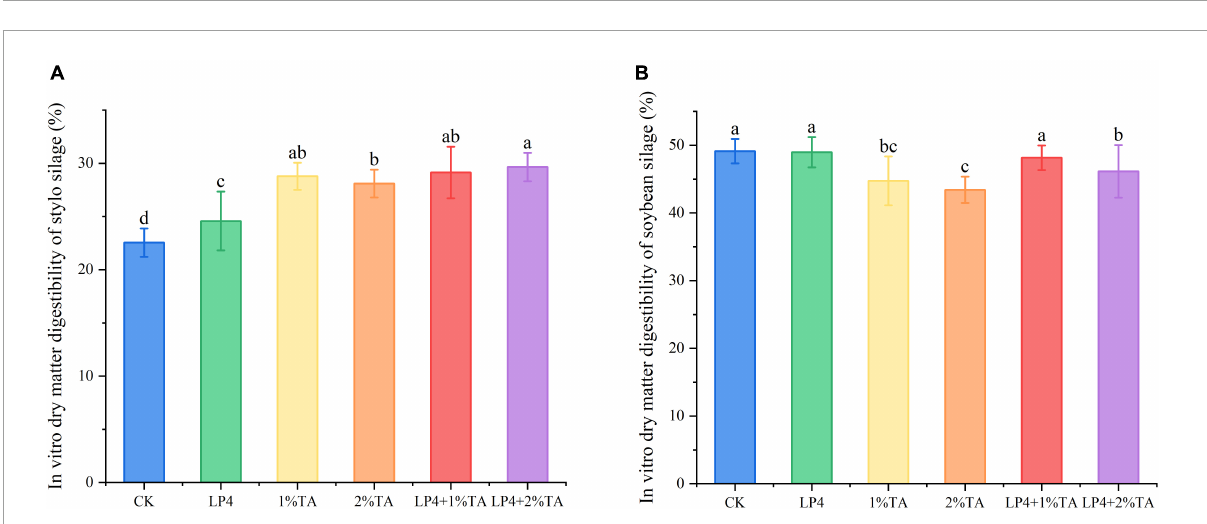
FIGURE2 In vitro dry matter digestibility of Stylosanthes silage (A) and whole-plant soybean (WPS) silage (B) in 48 h. Different letters over the bars indicate significant differences ( P <